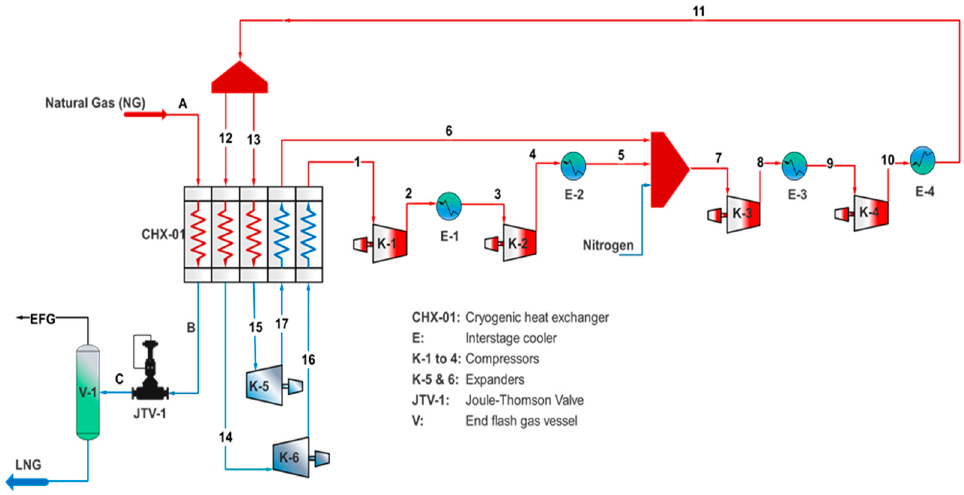
Figure 2. Schematic diagram of the N 2 dual expander LNG process.